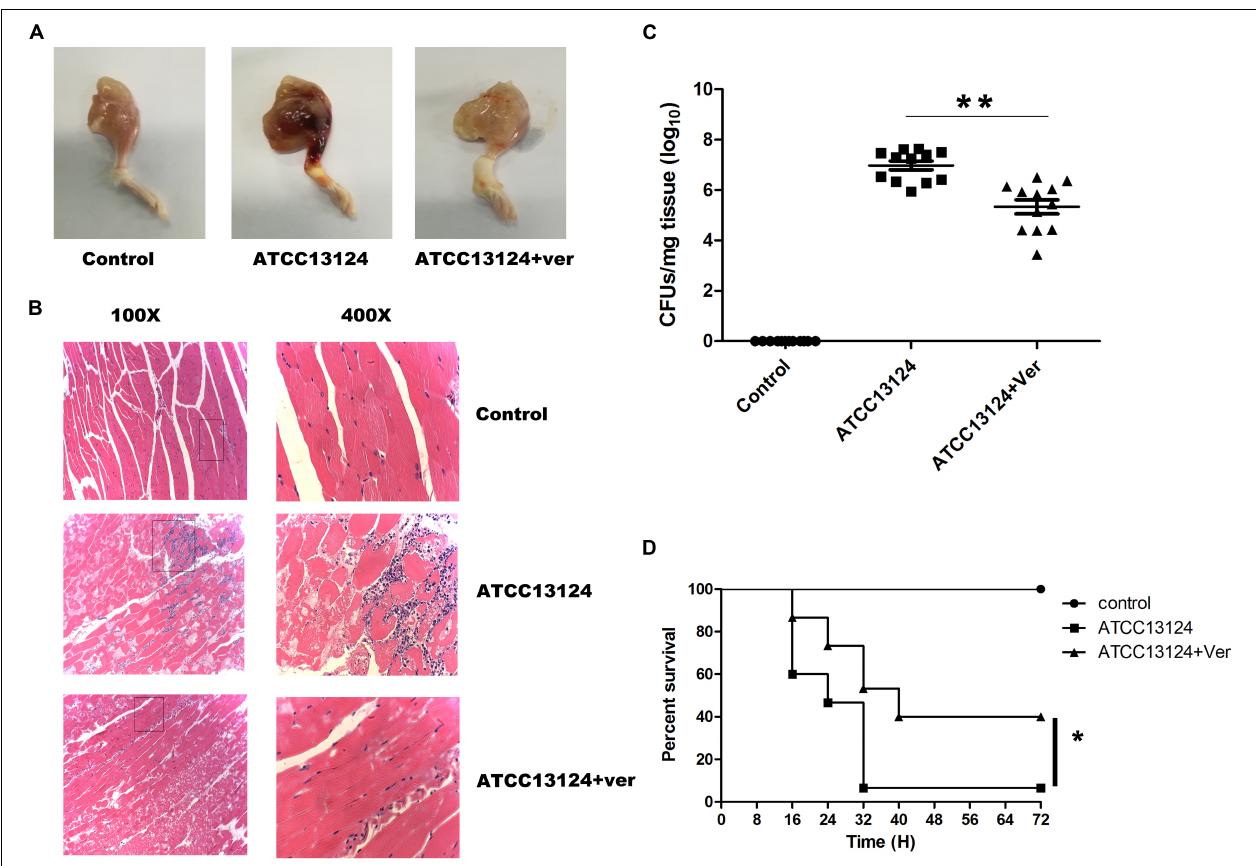
FIGURE 5 | Verbascoside protected mice from C. perfringens gas gangrene. (A) Pathologic photographs and (B) tissue sections of the leg tissues of mice administered the indicated treatment, in which the tissue section magnifications are 100 × (eyepiece 10 × , objective lens 10 × ) and 400 × (eyepiece 10 × , objective lens 40 × ). (C) The bacterial load of the leg muscles was measured 48 h after infection using a plated assay. Three independent experimental results were subjected to statistical analysis (* P < 0.05 and ** P < 0.01). (D) After injection of 2 × 10 8 CFUs of C. perfringens , treatment with DMSO or verbascoside was performed, and the survival rate was recorded every 8 h for 72